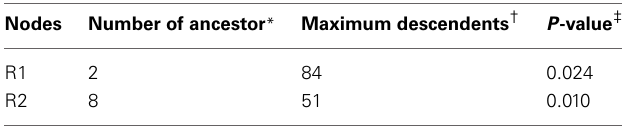
Table 1 | Relative cladogenesis (RC) test of the phaseoloid legumes. Nodes with diversification rate shift are shown on Figure 1.